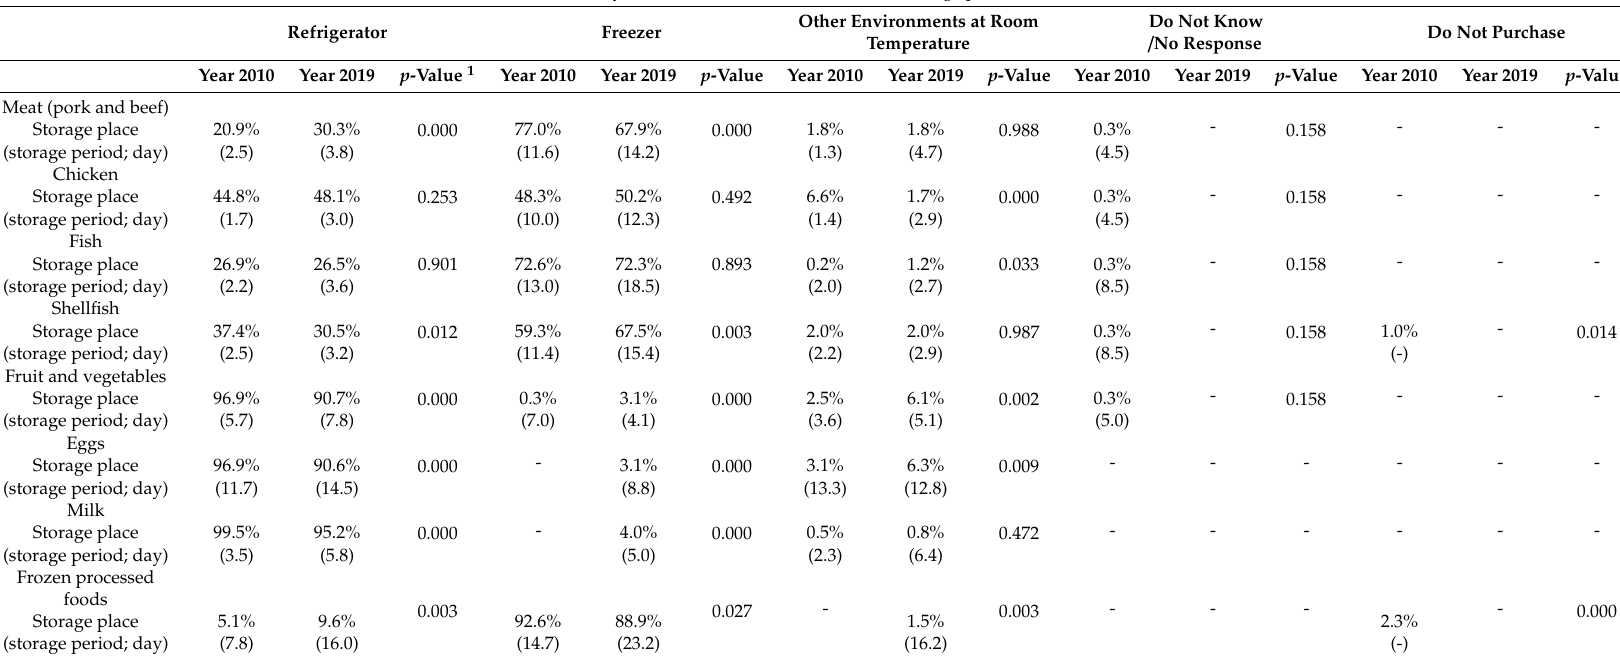
Table 4. The storage place and periods for specific foods in Year 2010 and Year